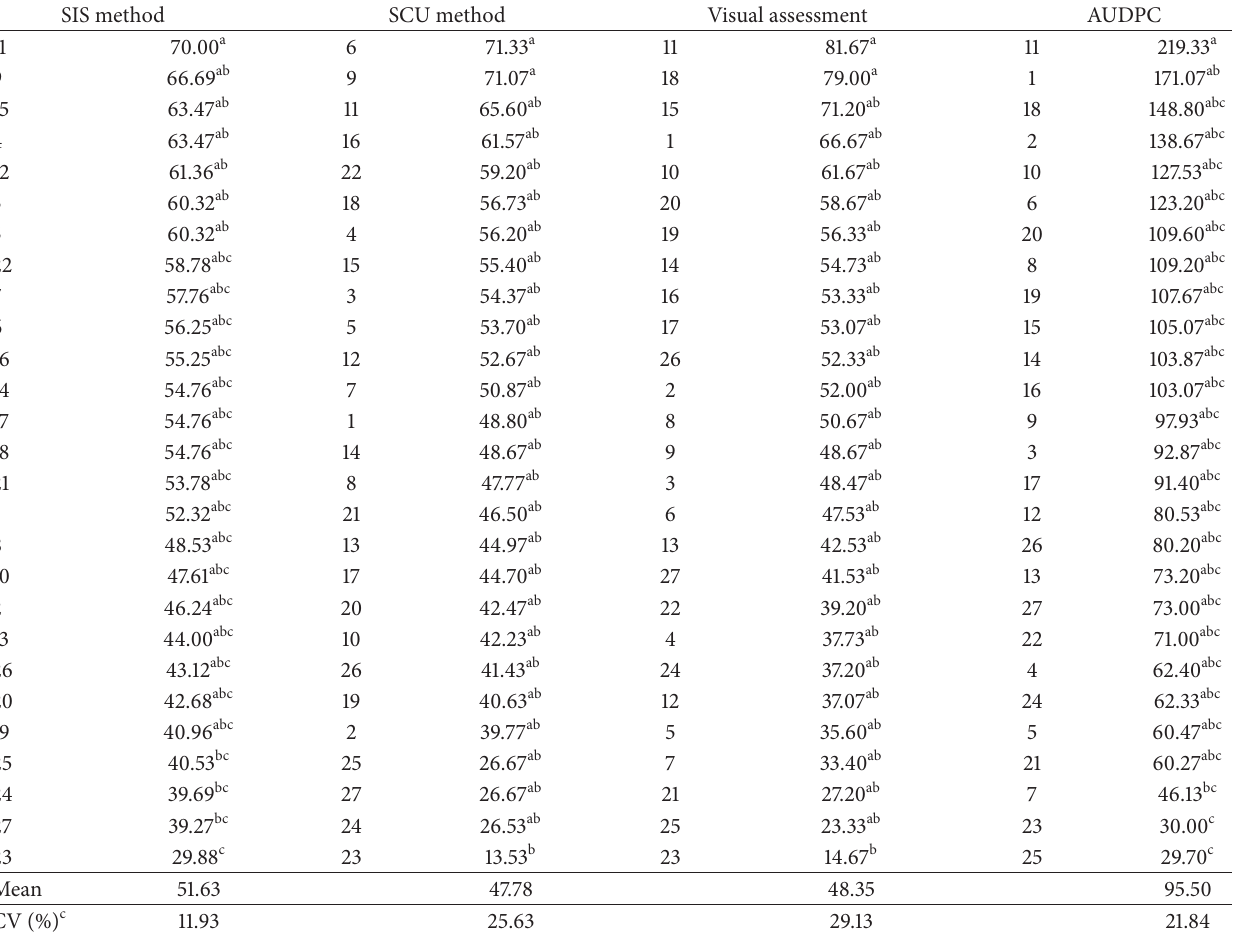
Table 2: Blast severity and the area under the disease progress curve (AUDPC) on rye and triticale spikes assessed visually and by analysis of digital